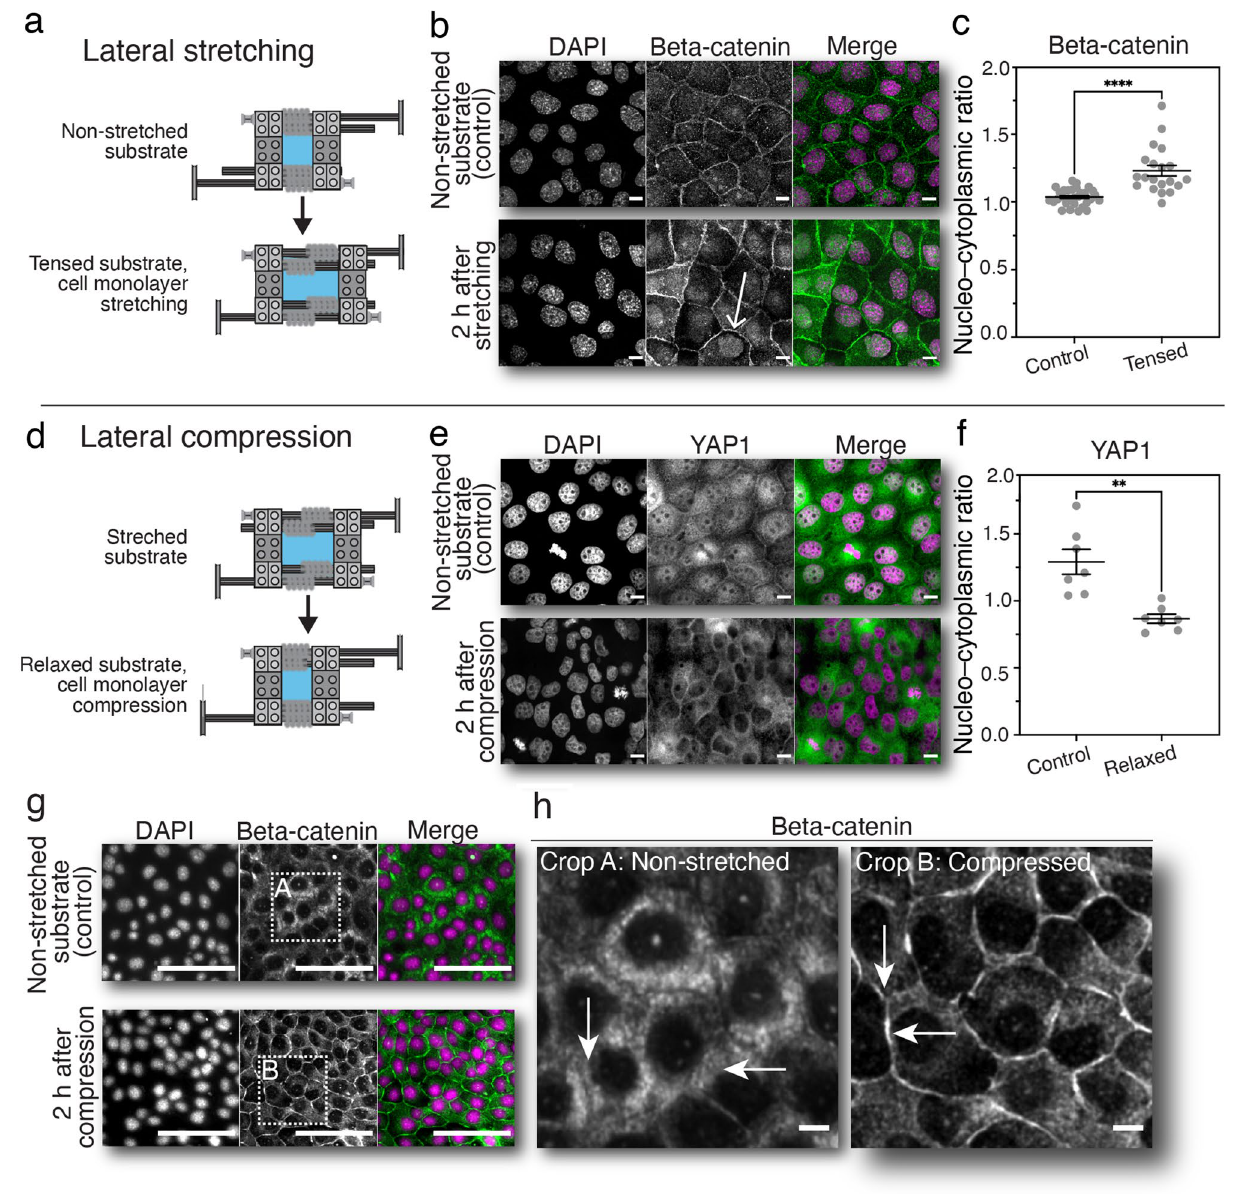
Figure 2. Manual cell stretching and compression experiment with Brick Strex S. Epithelial cell monolayers were grown on silicon membranes and subjected to stretching or compression in Brick Strex S device. ( a ) Epithelial stretching experiment, where epithelium was subjected to a 25% strain. ( b ) Representative maximum intensity Z-projection confocal microscopy images showing cells before (relaxed substrate) and after stretching (2 h after stretching). Cell were stained with DAPI to highlight the nuclei (magenta) and immunolabelled against β -catenin (green). ( c ) Quantification of the nucleo-cytoplasmic ratio of β -catenin after single stretch of the substrate in comparison to unstretched control samples. ( d ) Lateral compression experiment of the epithelial monolayer. ( e ) Cells were stained with DAPI to highlight the nuclei (magenta) and immunolabelled against YAP1 (green). ( f ) Quantification of the nucleo-cytoplasmic ratio of YAP1 in response to compression. ( g ) Similar lateral compression experiments as shown in e. The cells were stained with DAPI to highlight the nuclei (magenta) and immunolabeled against β -catenin (green). ( h ) blow-up images of the β -catenin staining shown in g. Scale bars 10 µ m. Error bars represent the standard error of the mean (SEM). Statistical analyses were performed using an un-paired Student´s t-test when comparing between cells before and after stretching/ compression (****p < 0.0001; **p <